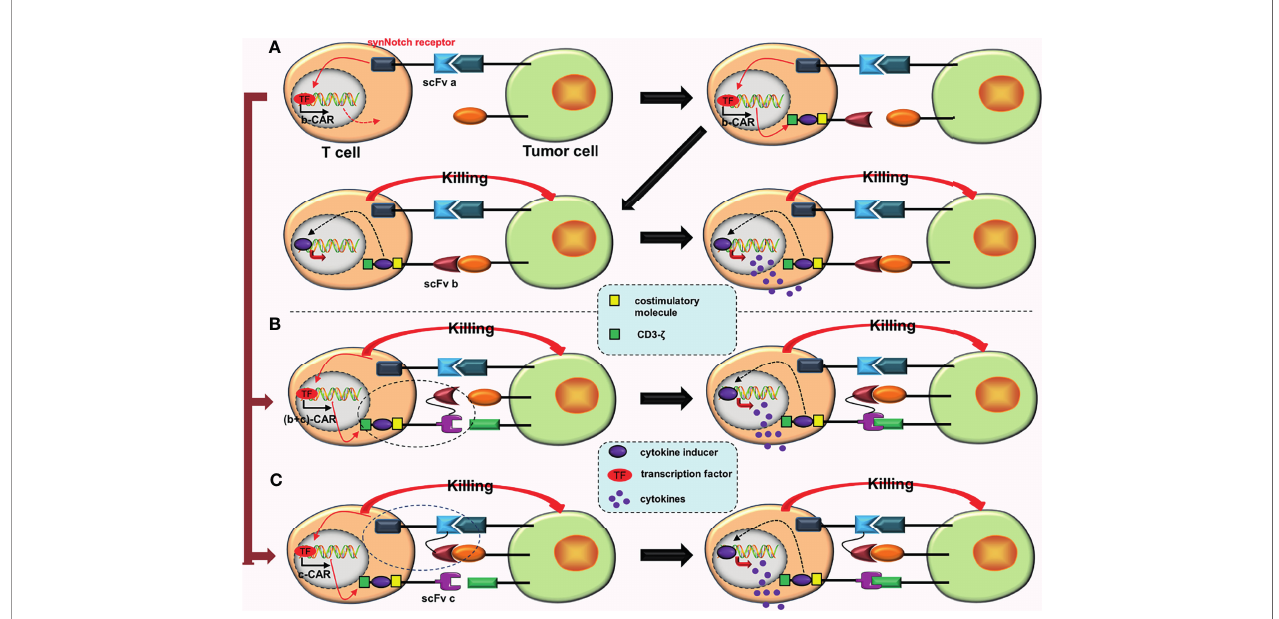
FIGURE 7 | Some conjectures about special CARs based on the fourth-generation CARs. (A) The SynNotch receptor binds to the corresponding tumor antigen (a), inducing the expression of b-CAR, which is a fourth-generation CAR. When activated, the CAR-T cell will release extra cytokines. (B) The SynNotch receptor binds to the corresponding tumor antigen (a), which induces the expression of (b + c)-CAR (a tanCAR based on the fourth-generation CAR). When activated, the CAR-T cell releases extra cytokines. (C) The SynNotch receptor has two scFvs connected in tandem, and as long as one scFv binds to the corresponding tumor antigen, it will induce the expression of c-CAR (a fourth generation CAR); when activated, the CAR-T cell will also release extra